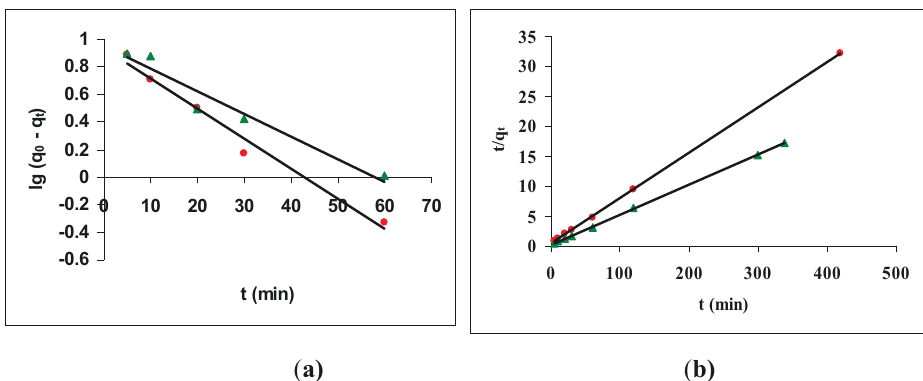
Figure 9. The applicability of the (a) pseudo-first order and (b) pseudo-second order kinetic models to the sorption of reactive dye Brilliant Red HE-3B on HPAN; ● - 80 mg L -1 , ▲ - 120 mg L -1 .